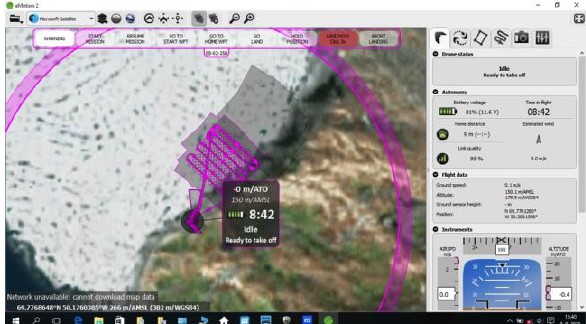
Figure 12. Two overlapping flights over the Egi glacier; the satellite image as the under layer is out of date and has a low resolution for precise navigation and orientation. The glacier face was, in September 2015, some hundred meters away from the depicted position, (Pavelka, 2015)